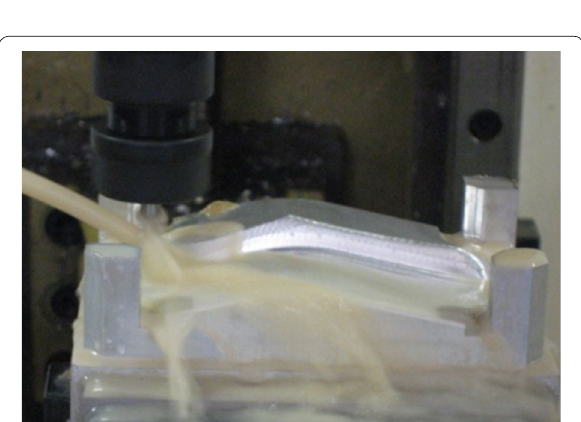
Figure 9 Machining a scoop mold on three-axis machine tool